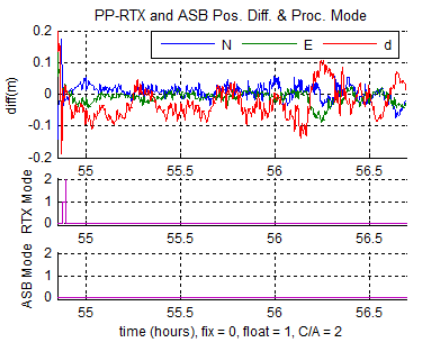
Figure 6: Position Difference, PP-RTX vs. ASB for one